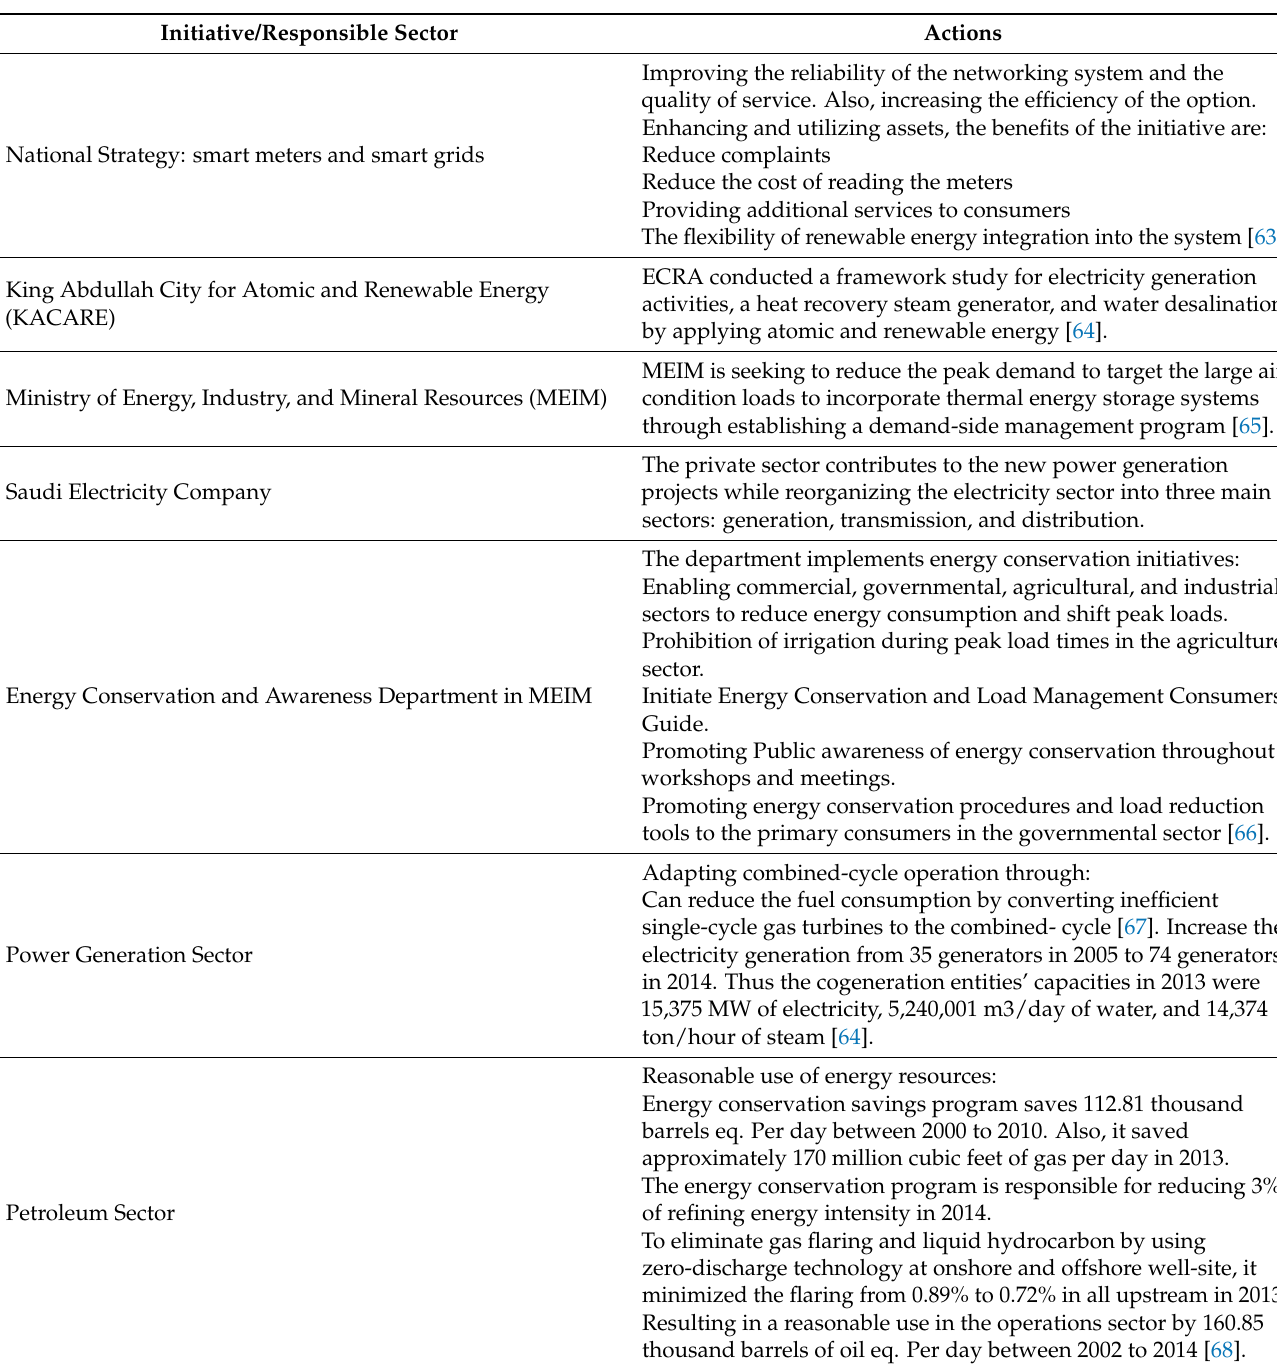
Table A4. Energy, regulation, and policy actions in Saudi